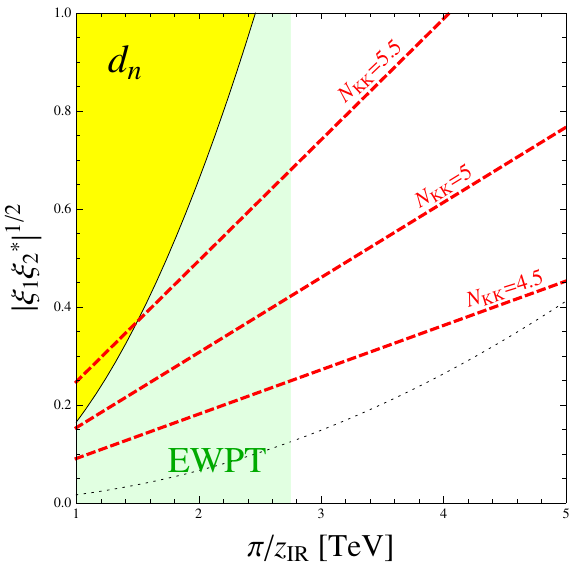
Figure 3 . Constraints from d n , electroweak, and (cid:13)avor data in 5D models with (cid:24) (cid:24) 3 2 SU(3) u . The contribution of the dim-6 operators to d n is dominated by the second term in (4.4). We took j b u ( f 3 ) 31 j = j (cid:24) 1 j and d n = Im( d u ) 11 , with (cid:24) i de(cid:12)ned in the basis with diagonal Y u . The yellow area is excluded by current bounds, whereas the dotted black line shows the limit for a constraint 10 times stronger. An indicative measure of the electroweak constraints on (cid:25)=z IR is shown by the light green area. A conservative bound from (cid:13)avor physics can be obtained assuming that the IR-localized operator ( u (cid:13) (cid:22) (cid:30)(cid:30) y u ) 2 is generated at the 5D cuto(cid:11) with a coe(cid:14)cient of order (16 (cid:25) 2 ) 3 = (cid:3) 10 , which is the maximal value allowed by calculability. The parameter space excluded 5 by imposing the constraint from D 0 (cid:0) D 0 is above the dashed red lines, obtained with (cid:3) 5 L = N KK (cid:25) and (cid:30) 2 ( z IR ) L 3 =